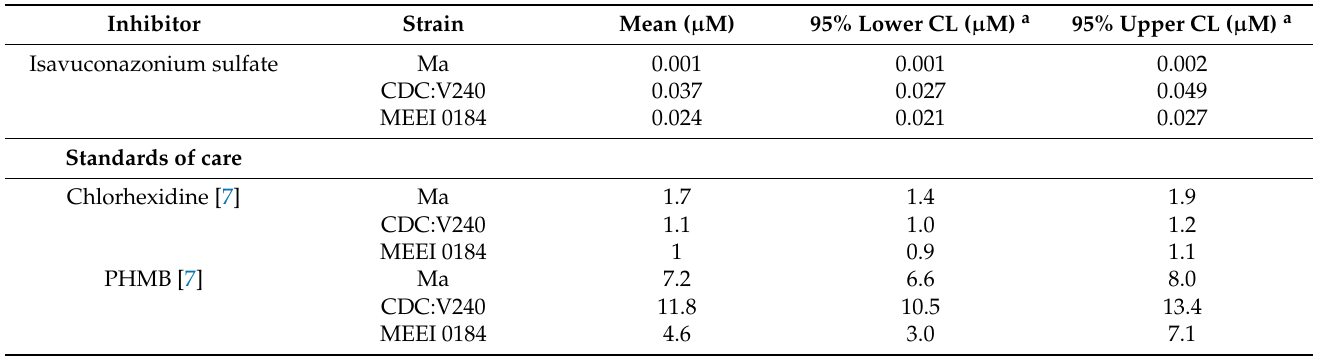
Table 1. EC 50 values of isavuconazonium sulfate against trophozoites of Acanthamoeba T4